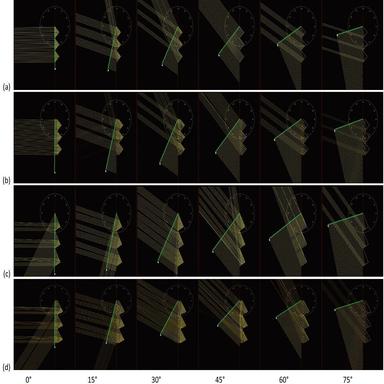
Reflection of beam light as a function of beam altitude angle, shown for a variety of two-surface retroreflectors. Shown here: (a) symmetric open mirrors; (b) symmetric open mirrors behind a low-index glass window (n = 1.5); (c) asymmetric open mirrors; (d) asymmetric open mirrors behind a low-index glass window (n = 1.5); (e) symmetric low-index glass (n = 1.5) right triangular prisms; (f) system e plus mirror backing; (g) asymmetric low-index glass (n = 1.5) right triangular prisms; (h) system g plus mirr